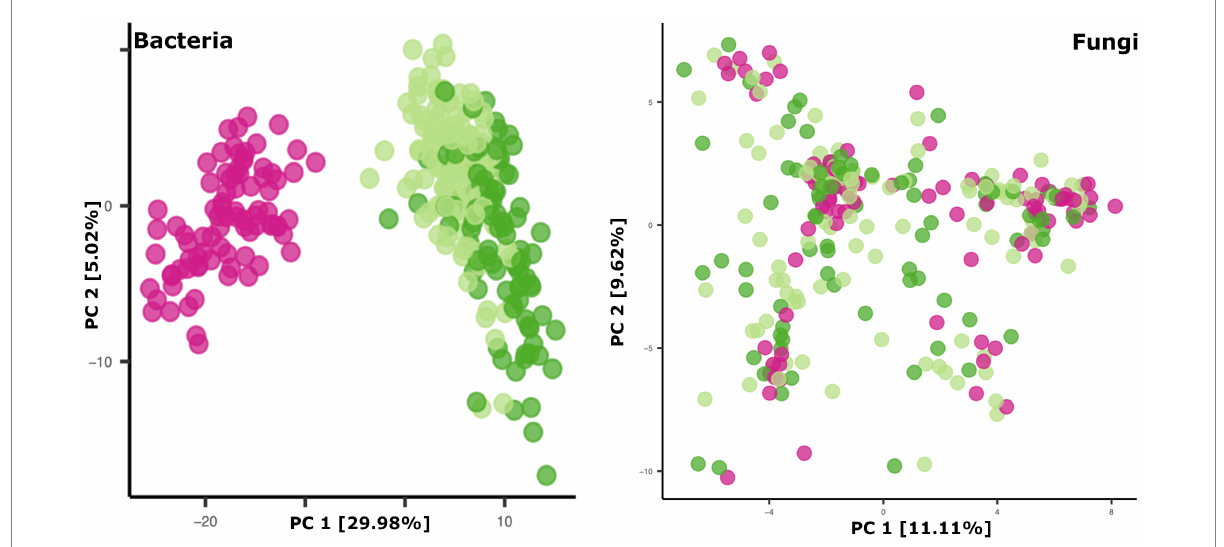
FIGURE 3 Principal coordinates plots of microbial beta diversity in breastmilk (pink dots), 1-month feces (light green dots), and 6-month feces (dark green dots). Bacterial community data points (left panel): n = 85 for breastmilk, 124 for 1-month feces, and 97 for 6-month feces. Fungal community data points (right panel): n = 91 for breastmilk, 115 for 1-month feces, and 84 for 6-month